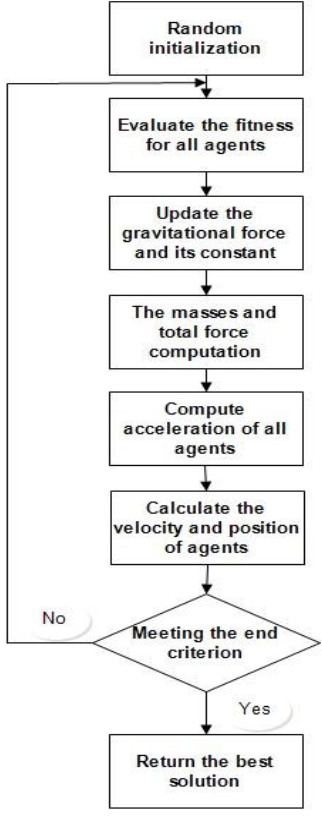
Figure 5. The hybrid PSOGSA algorithm flowchart.